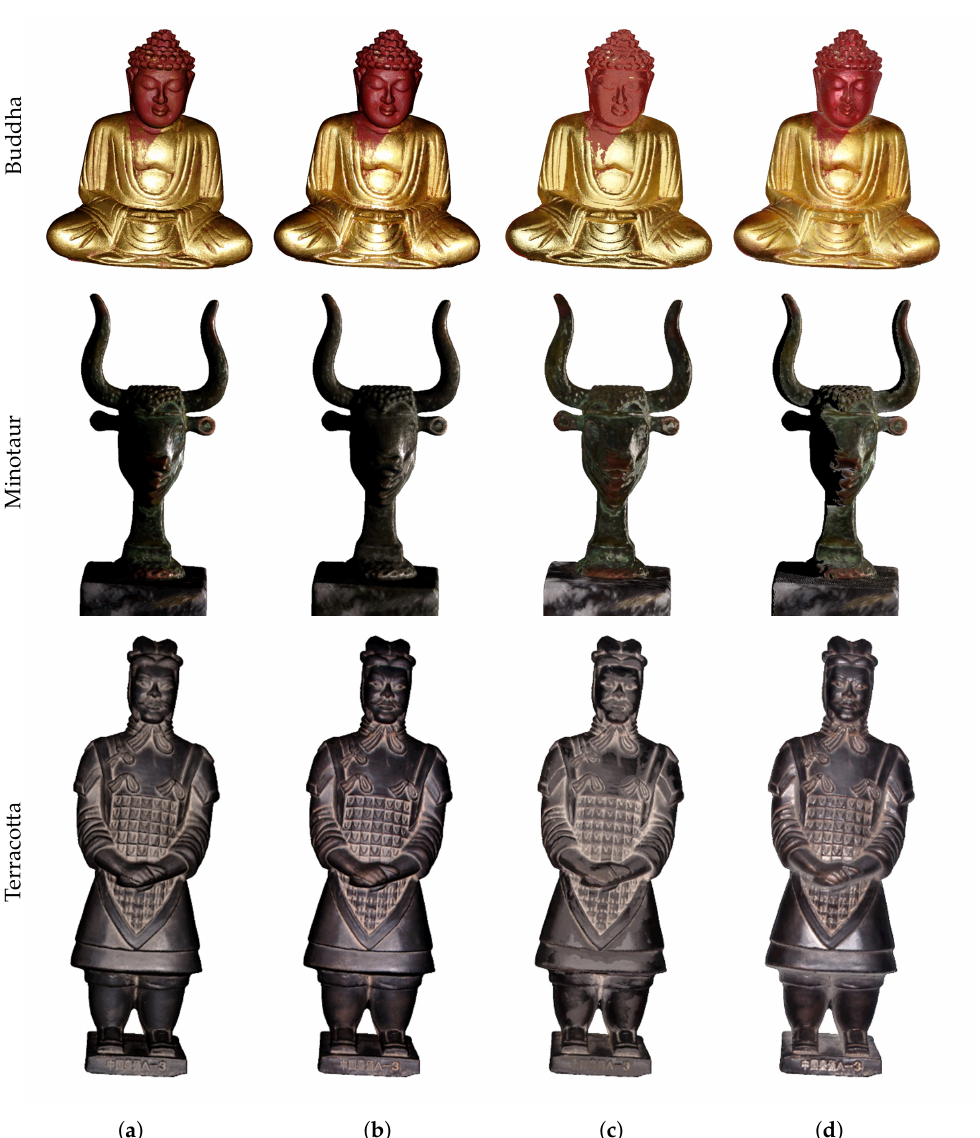
Figure 3. Visual comparison on Buddha, Minotaur, and Terracotta dataset: ( a ) Ground truth photo- graph; ( b ) DEN; ( c ) DSC; ( d )